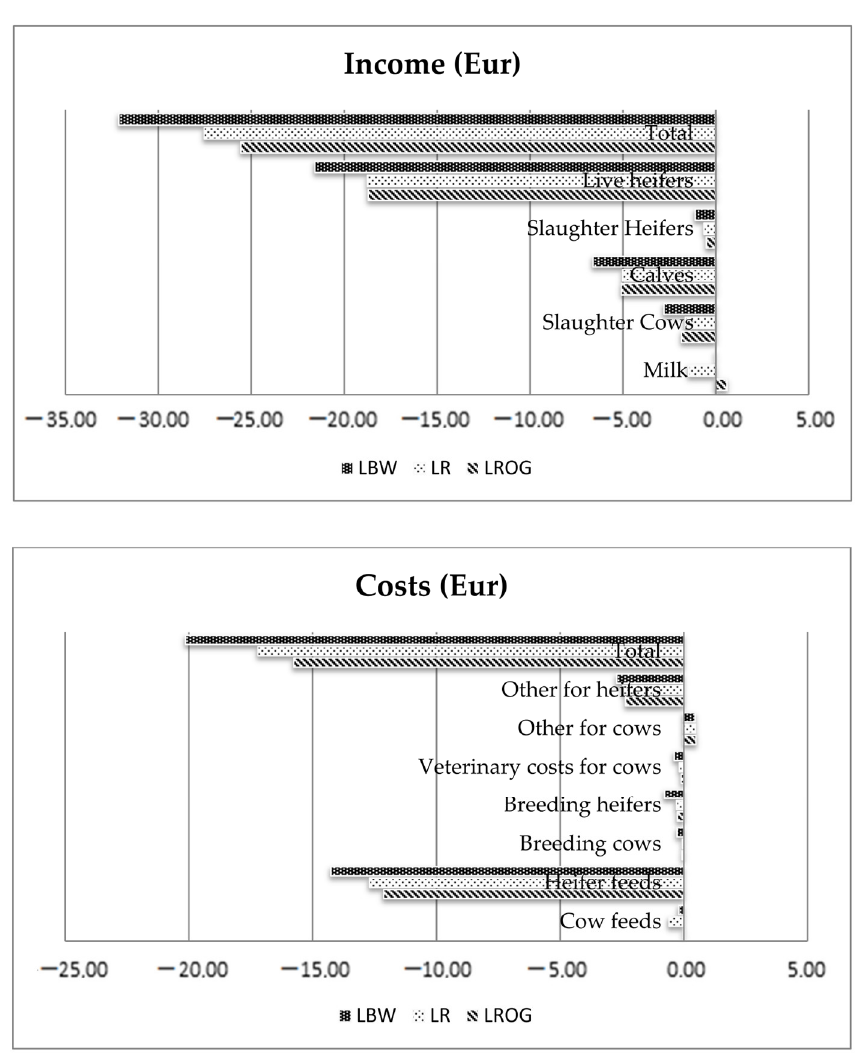
Figure 2. Economic income and costs (in Euro) caused by an increase in stillbirth rate of 1 percentage point for the breeds LBW, LR and LROG.